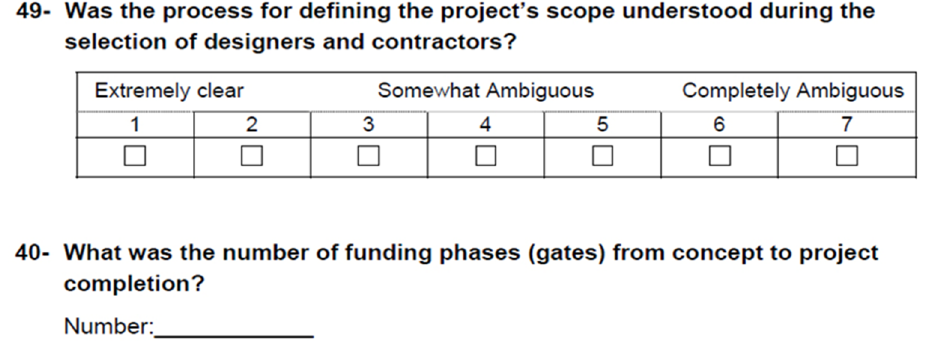
Figure 3. Sample Survey Questions.